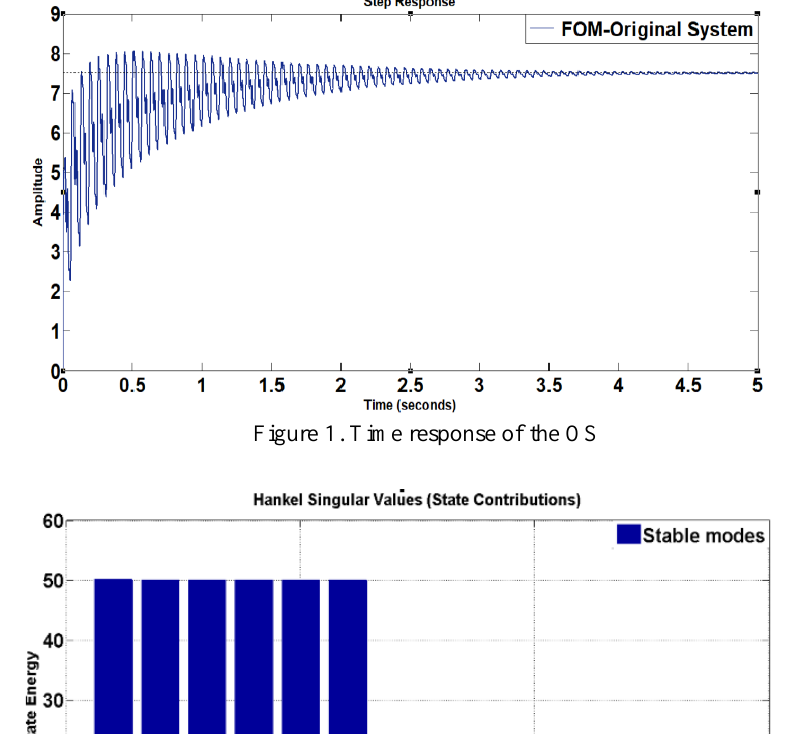
Figure 2. Bar chart Hankel singular value plot of the OS